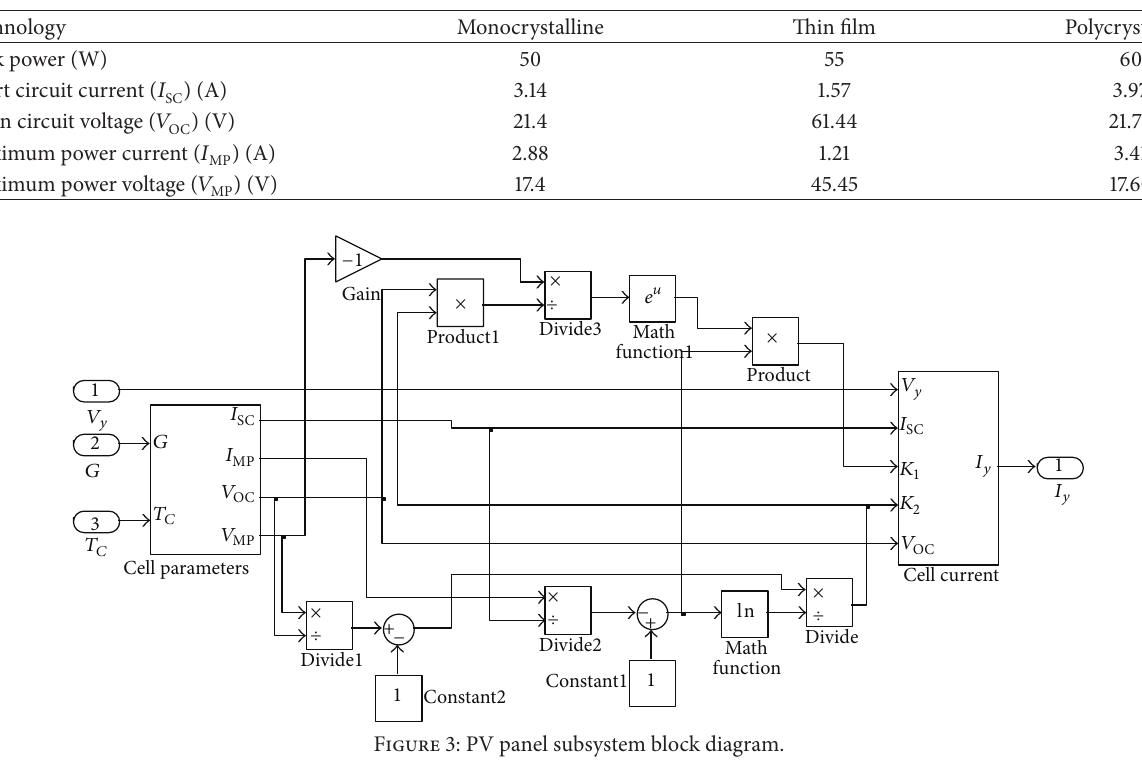
Table 1: Characteristic parameters of PV panels.